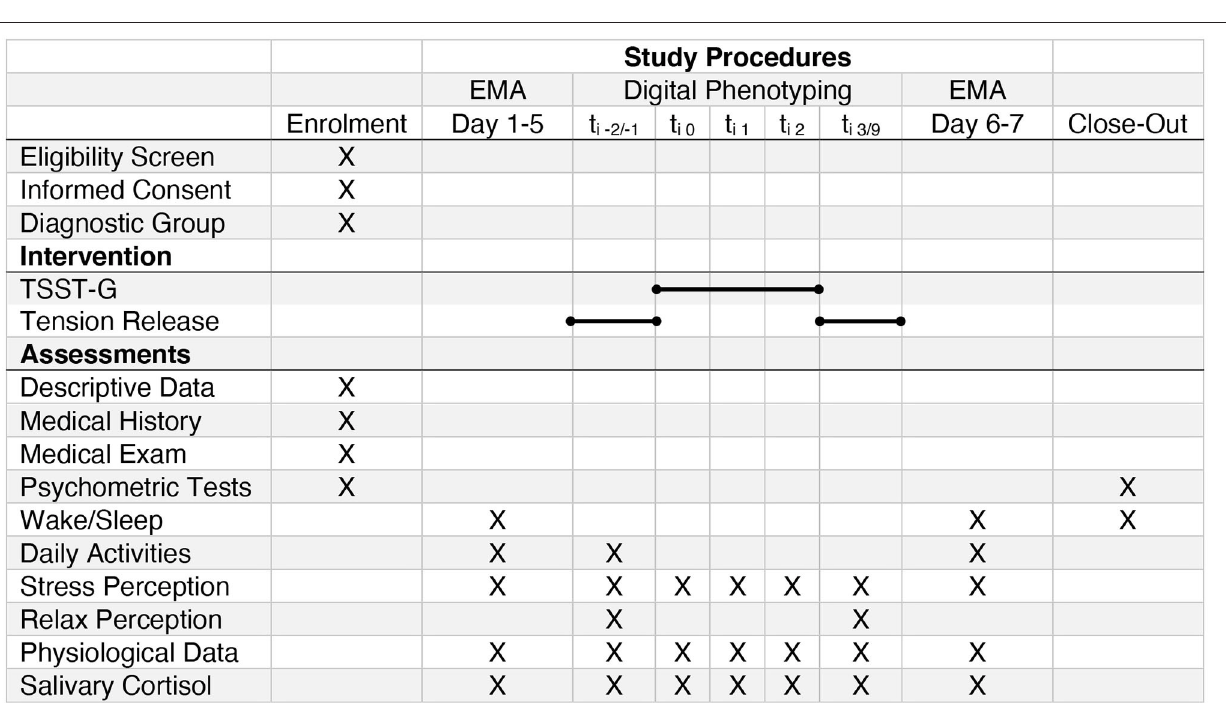
FIGURE 2 | SPIRIT Study Schedule (EMA, Ecological Momentary Assessment; TSST-G, Trier Social Stress Test for Groups). The bar denotes the different parts of the intervention (compare Figure 3 ). t i − 2 / − 1 briefing and tension release exercise previous to the TSST-G; t i1 TSST-G Speech; t i2 TSST-G Math; t i3 / 9 TSST-G debriefing and tension